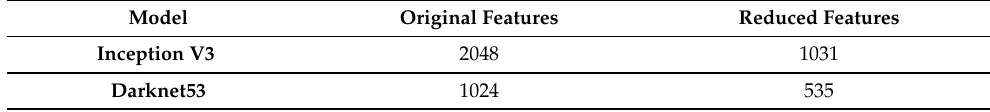
Table 1. MFO Results of Reduced